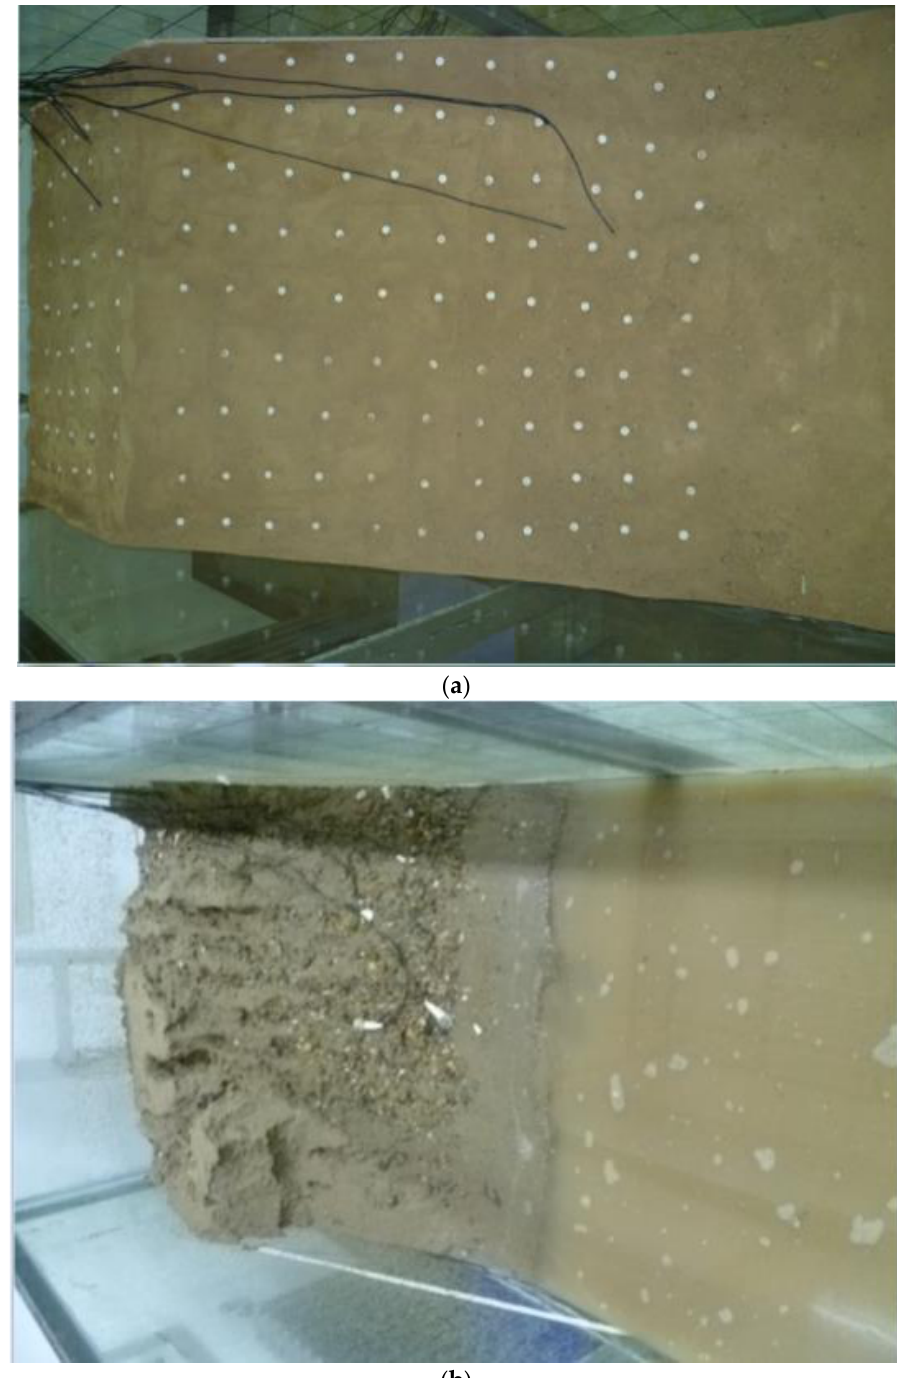
Figure 18. The slope sliding surface of the test: ( a ) the sliding surface of test at initial time; ( b ) failure mode of sliding surface at the end of slope.